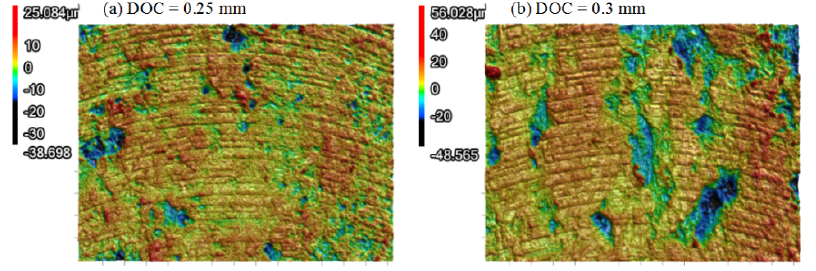
Figure 10. 3D morphologies of CF/PEEK samples (RA = 0 ° , LT = 0.1 mm): ( a ) DOC = 0.25 mm; ( b ) DOC = 0.3 mm.